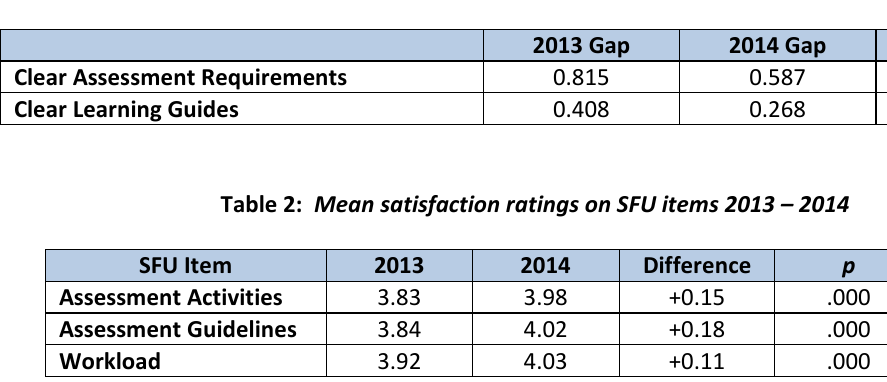
Table 1: CSS reported importance and performance gap (2013 and 2014)